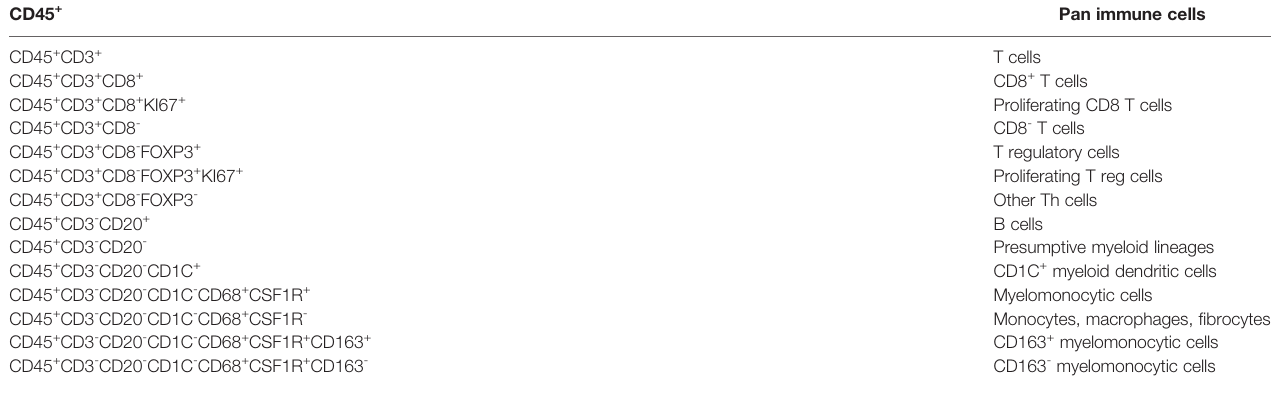
TABLE 3 | Marker combination used in manual gating in image cytometry. CD45 +